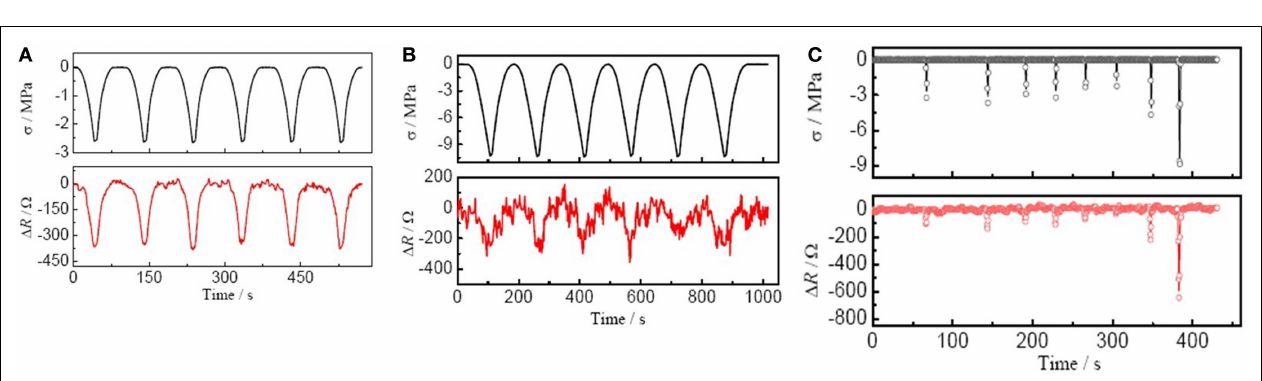
FIGURE 3 | Pressure-sensitivity of CNT filled cement mortar composites with NaDDBS and 1 wt.% of MWNT . (A) Under repeated compressive loading with amplitude of 2.5MPa. (B) Under repeated compressive loading with amplitude of 10MPa. (C) Under impulsive